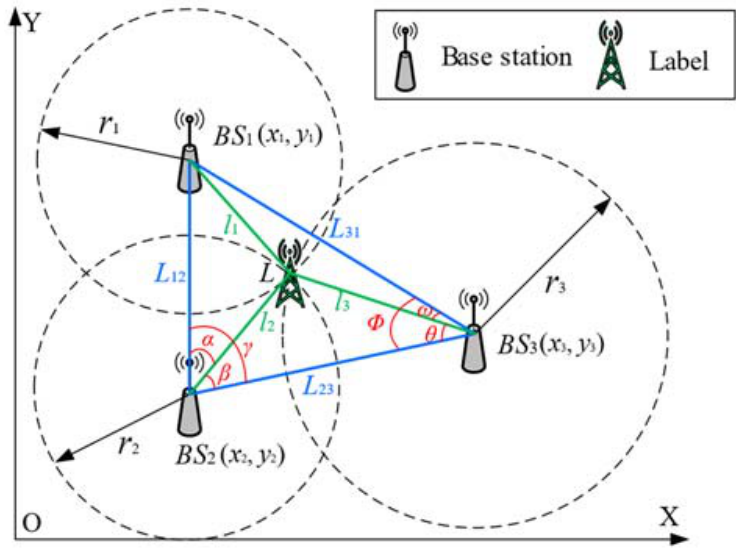
Figure 6. TOA algorithm principle.